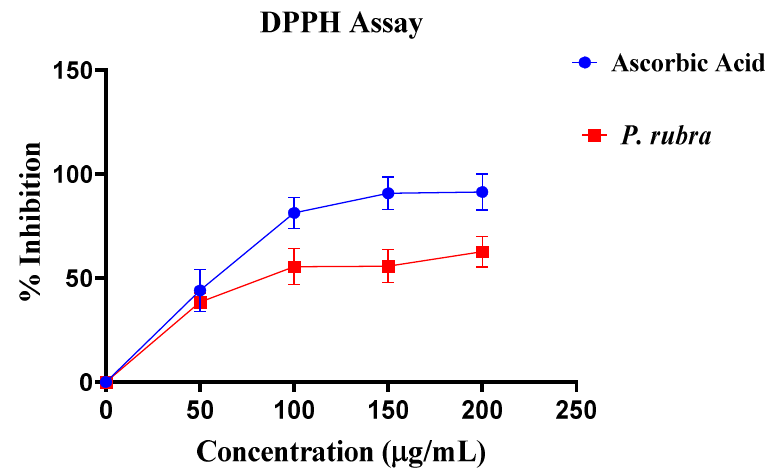
Figure 2. Antioxidant potential of P. rubra with respect to ascorbic acid by DPPH assay ( n =